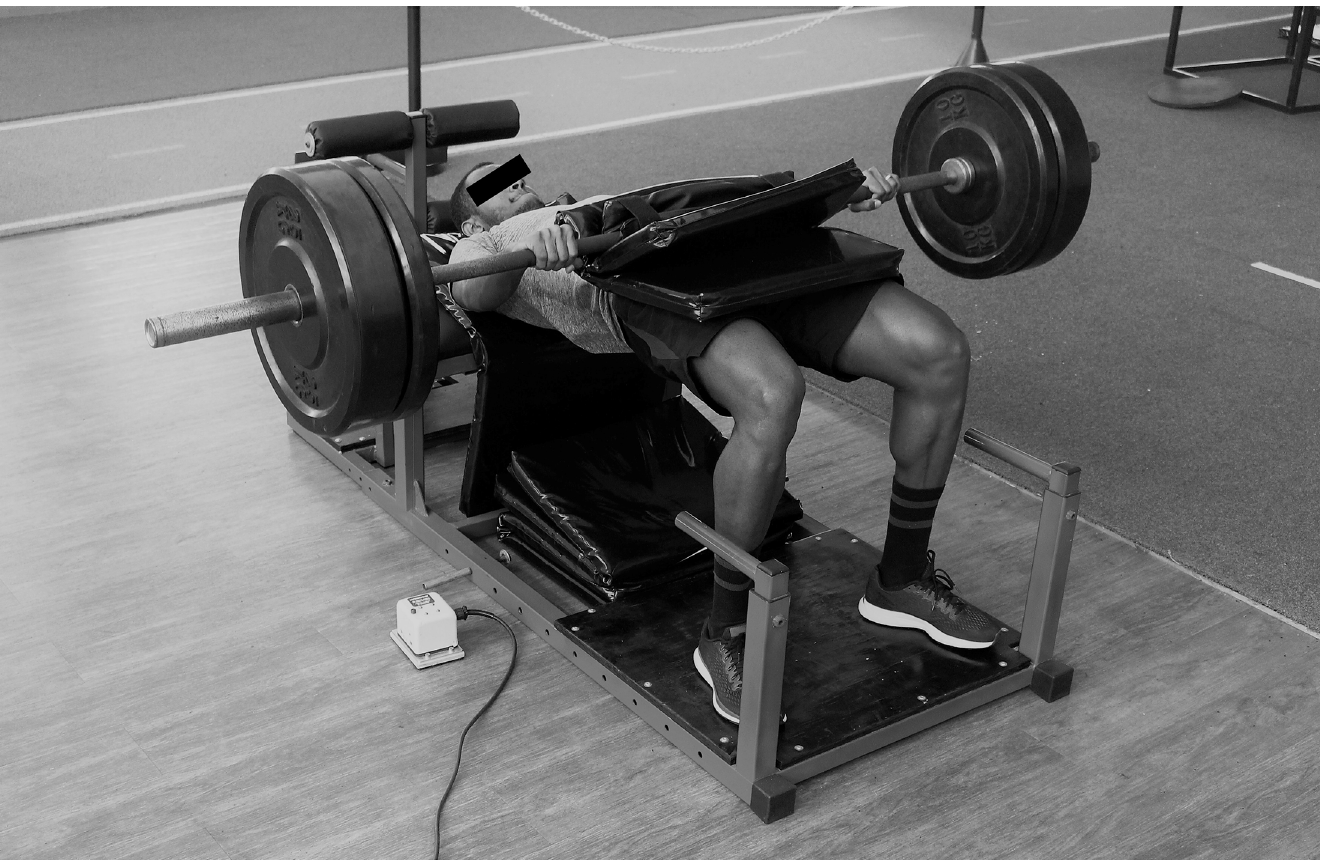
Fig 2. An Olympic sprinter performing a loaded hip-thrust at the optimum power zone.